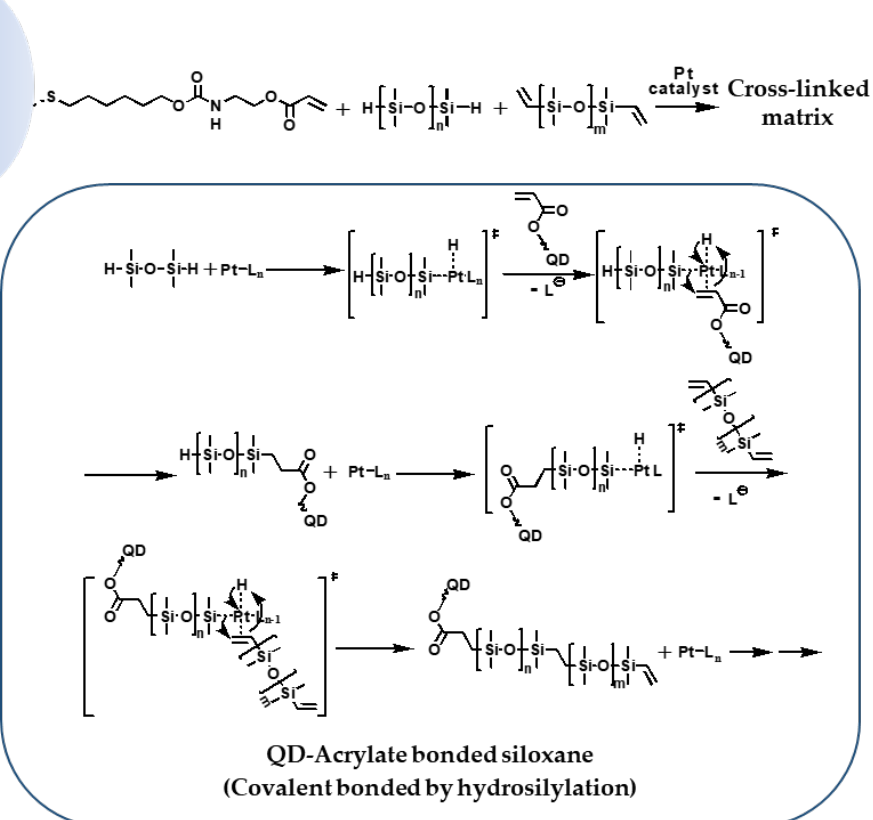
Figure 3. Schematic diagram of the hydrosilylation reaction between the functionalised QDs and the siloxanes in the presence of the platinum catalyst.